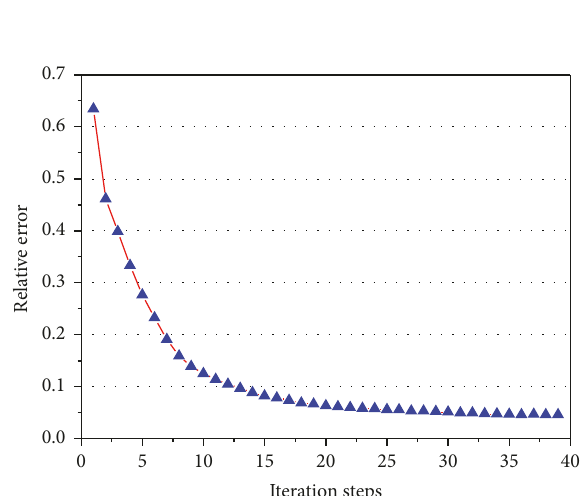
Figure 11: Relative error of iterations of the flat lens with 15 × 15 elements.